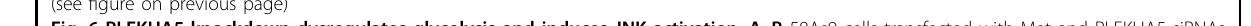
Fig. 6 PLEKHA5 knockdown dysregulates glycolysis and induces JNK activation. A , B 58As9 cells transfected with Met and PLEKHA5 siRNAs were subjected to immunoblot analysis with the indicated antibodies against proteins involved in apoptosis and cell cycle regulation ( A ) or intracellular signaling ( B ). C Cells were treated with increasing concentrations of anisomycin for 3 days and their viability was examined. D Cells treated with anisomycin were analyzed by immunoblotting with the indicated antibodies. E , F Cellular levels of glucose ( E ) and lactate ( F ) were quanti fi ed in 58As9 cells transfected with Met and PLEKHA5 siRNAs as described in the “ Materials and methods ” section. G Viability of 58As9 cells starved for pyruvate or glucose for 3 days. H Cells starved for glucose were subjected to immunoblotting with the indicated antibodies. I Viability of 58As9 cells treated with increasing concentrations of 2-deoxyglucose (2-DG) for 3 days. J Cells treated with 10 mM 2-DG for 1 day were subjected to immunoblotting with the indicated antibodies. Bars, SD ( n = 3). * P < 0.005; and ** P <